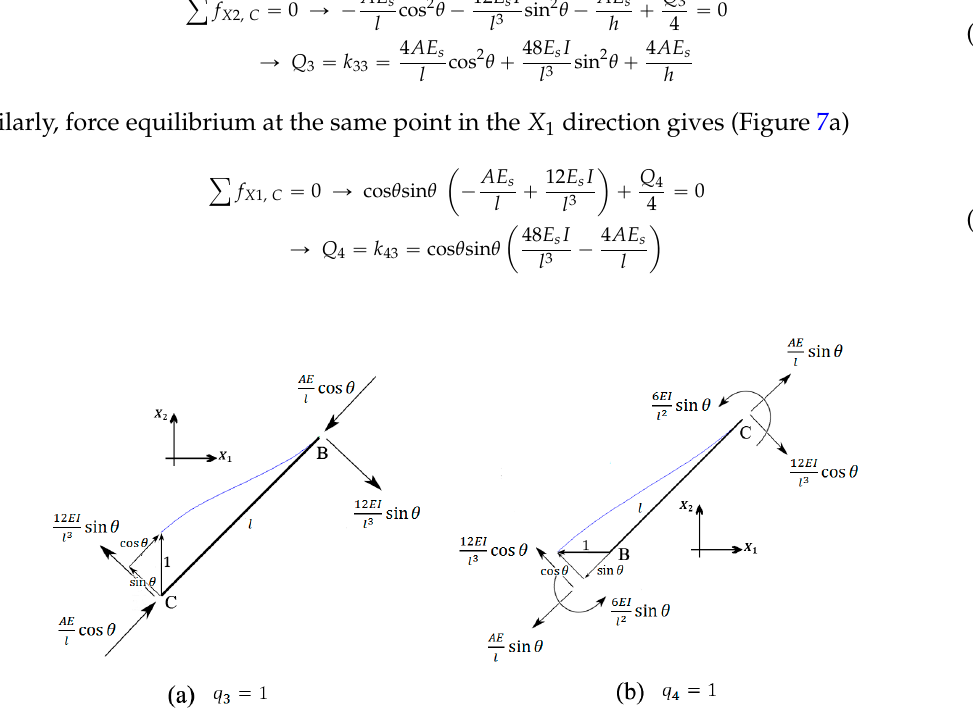
Figure 7. Free-body diagrams of strut BC in deformations ( a ) (cid:1869) (cid:2871) = 1 ; and ( b ) (cid:1869) (cid:2872) = 1 .